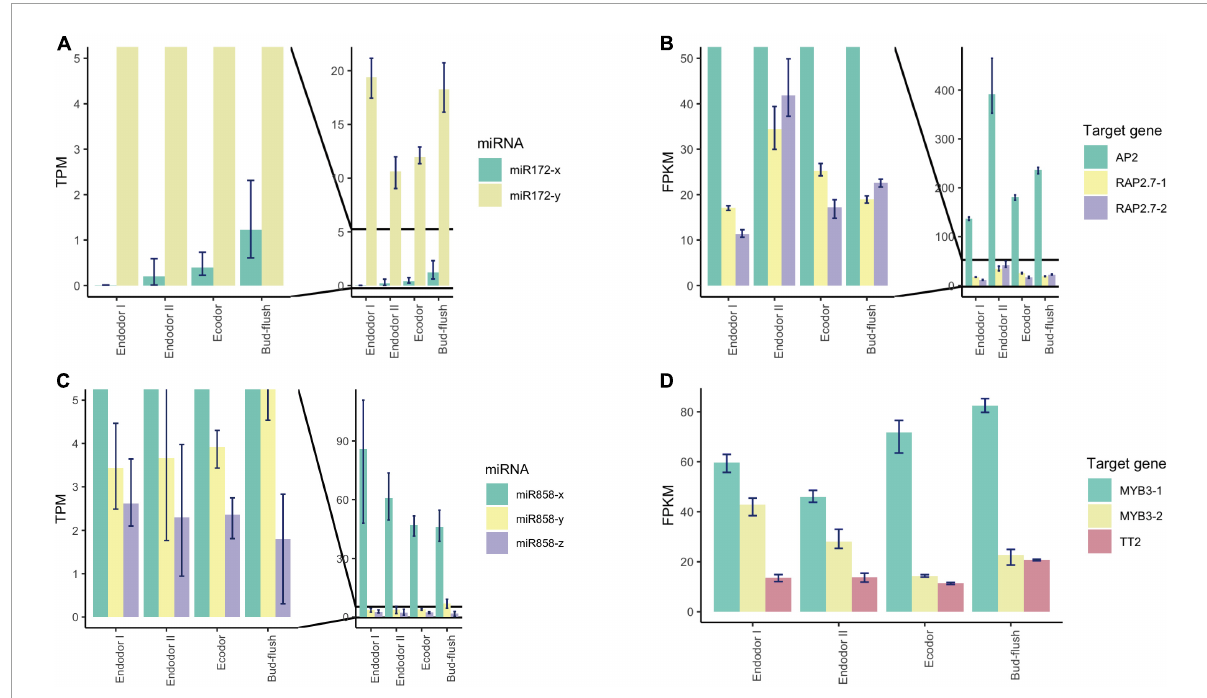
FIGURE7 Expression pattern analysis of miR172, miR858, and their target genes during floral bud break in P. mume . (A,B) The barplots revealing the expression levels of miR172-x/y (A) and their target genes (B) during floral bud break process. (C,D) The barplots revealing the expression levels of miR858-x/y/z (C) and their target genes (D) during floral bud